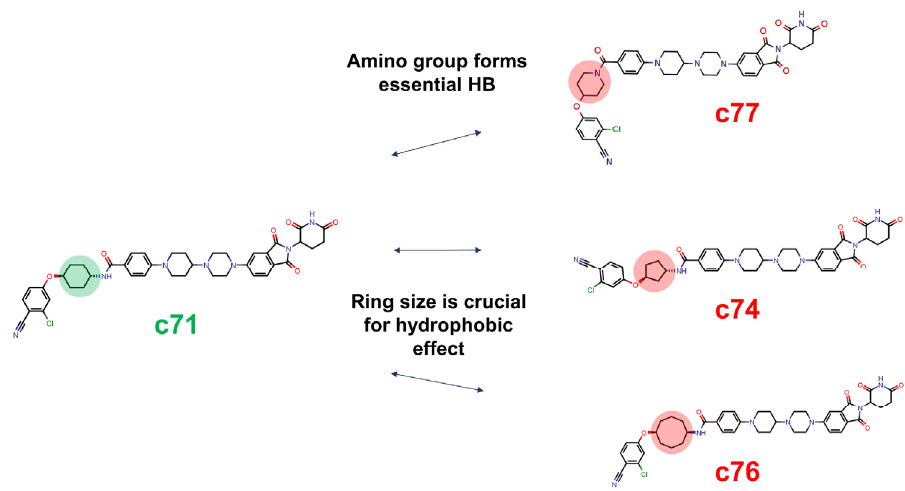
Figure 3. Warhead-related Degradation Cliffs. The arrows connect compounds included in the same pair, and the features responsible for the DC pair are highlighted in green (active-compound-related modification) or red (inactive-compound-related modification).